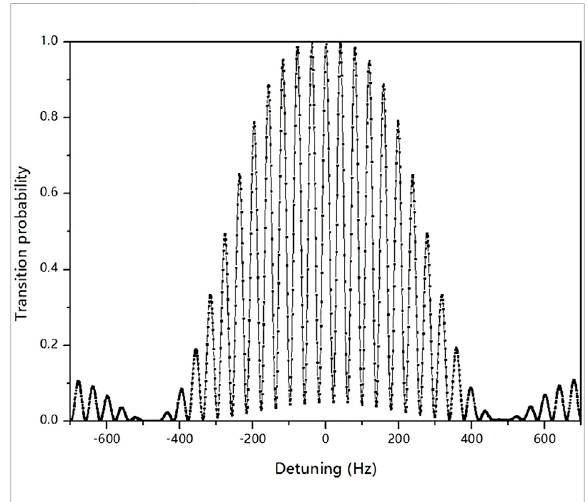
FIGURE 6 Typical Ramsey fringe. The linewidth of the central fringe is 20.0 Hz, and the signal-to-noise ratio is